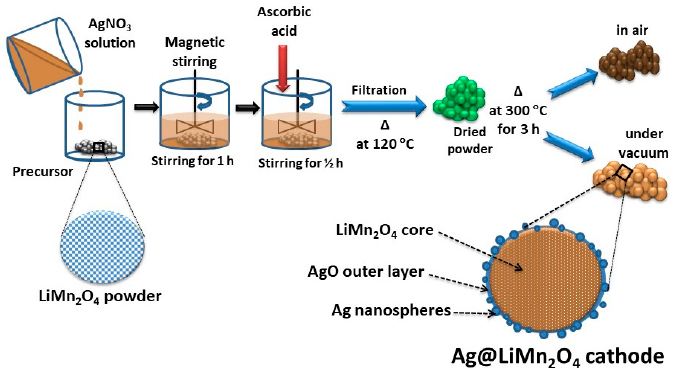
Figure 1. Schematic representation of the Ag coating process of LiMn 2 O 4